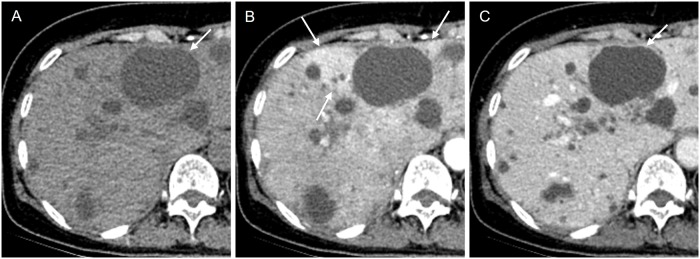
A 65-year-old female patient with an infected cyst (H10 in Fig 2).(A) On the pre-contrast CT image, a proven 6 cm infected cyst (arrow) shows no remarkable finding. (B) On the arterial phase image, there is perilesional hyperemia around the cyst (arrows). (B, C) On the arterial or delayed phase image, no discernible wall thickening is noted. In this case, arterial hyperemia is the only clue for cyst infection.